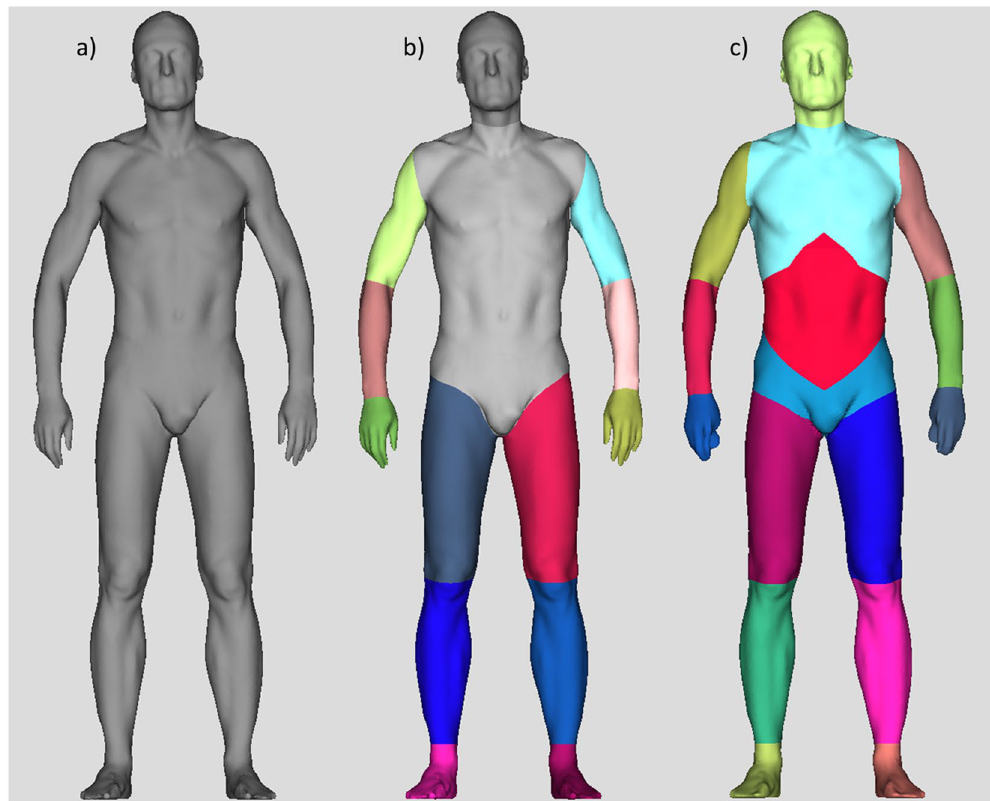
Figure 1. Automated determination of different body volumes based on 3D body scans. The 3D body scanner allows determination of the overall body volume (panel a) and of different body volume parts (panel b), including the torso volume (light grey, panel b). Based on scans with hemispherical markers attached to the participants’ skin to palpable anatomical limit points of the abdominal volume, a new algorithm was derived, now enabling automated determination of abdominal volume (red, panel